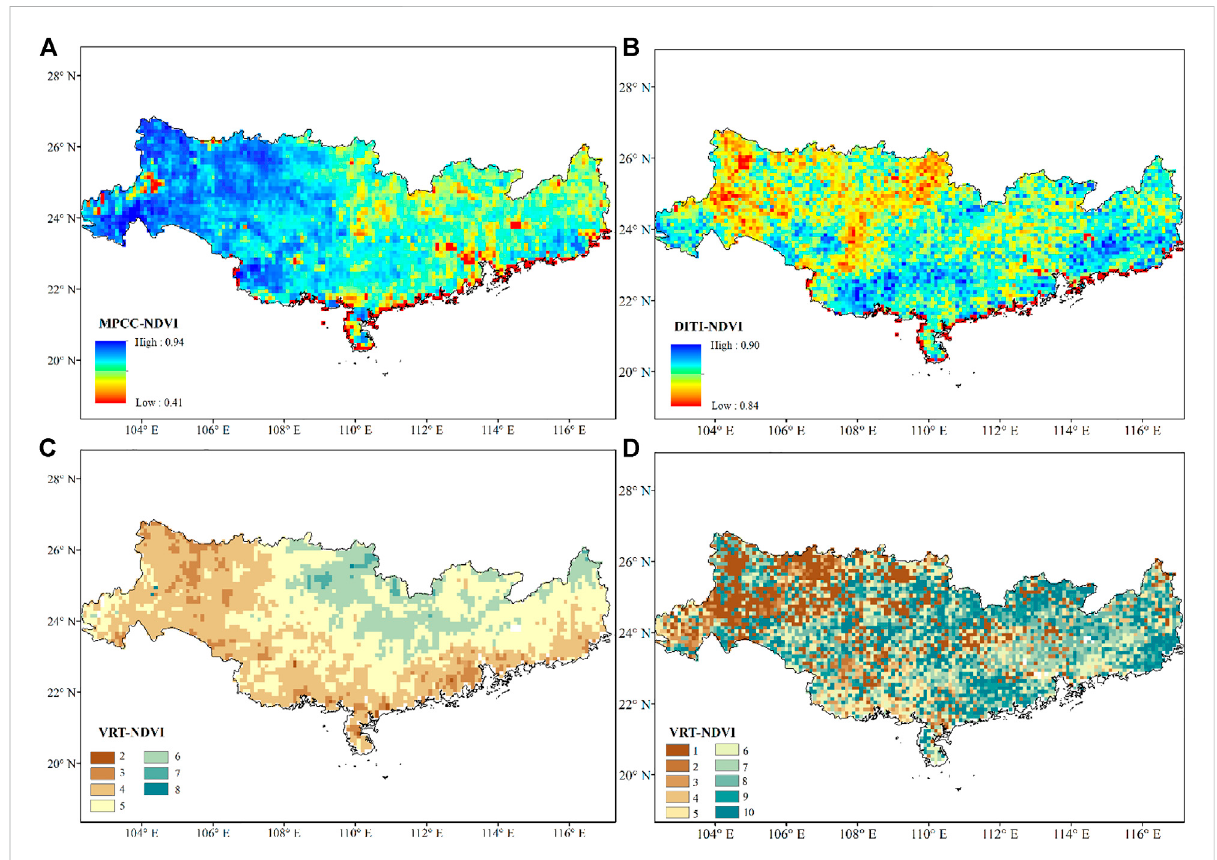
FIGURE 5 Spatial distributions of the MPCC (A) and the DITI (B) and corresponding VRT (C,D) are based on the